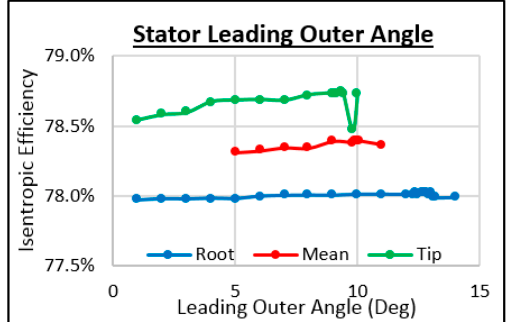
Figure 22. Study of the stator leading outer angle.